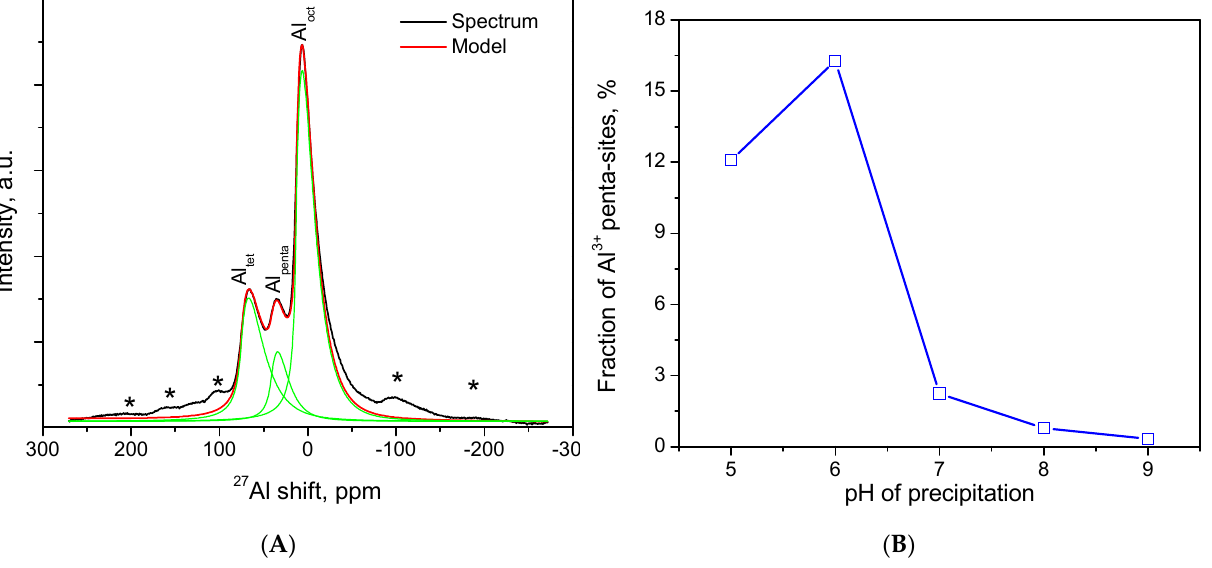
Figure 10. NMR spectrum for Al-5 sample, where asterisked (*) signals refer to rotational wiggles Figure 10. Deconvolution (green line) of the NMR spectrum (fitting—red line, experimental data— ( A ) and dependence of penta-sites of alumina on the precipitation pH ( B ). black line) for Al-5 sample, where asterisked (*) signals refer to rotational wiggles ( A ) and dependence of penta-sites of alumina on the precipitation pH ( B